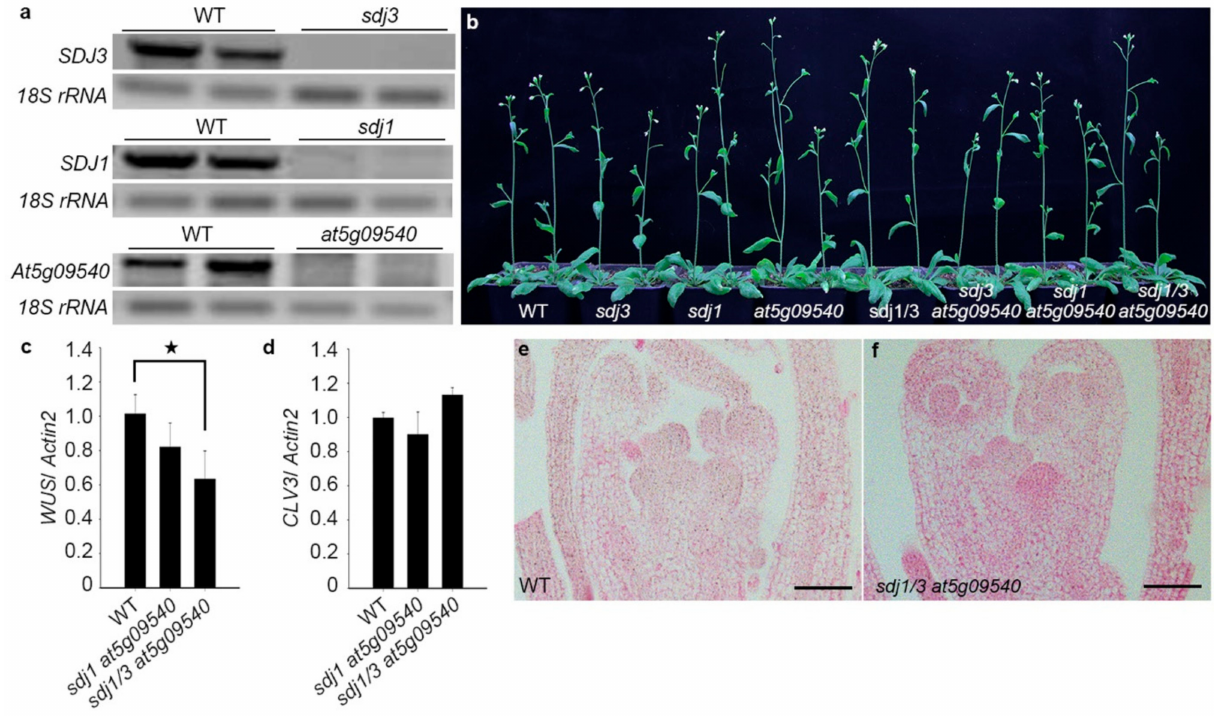
Figure 7. DnaJ protein regulate WUS mRNA expression. ( a ) RT-PCR analysis of of relative genes in sdj3 , sdj1 and at5g09540 mutants. ( b ) Growth phenotype of WT, sdj3 , sdj1 , at5g09540 , sdj3 sdj1 , sdj1 at5g09540 , sdj3 at5g09540 , and sdj3 sdj1 at5g09540 plants. ( c , d ) WUS mRNA level and CLV3 mRNA level in WT and sdj3 sdj1 at5g09540 plants by quantitative RT-PCR analysis. Student-t test, * p < 0.05 ( e , f ) SAM histology of WT and sdj3 sdj1 at5g09540